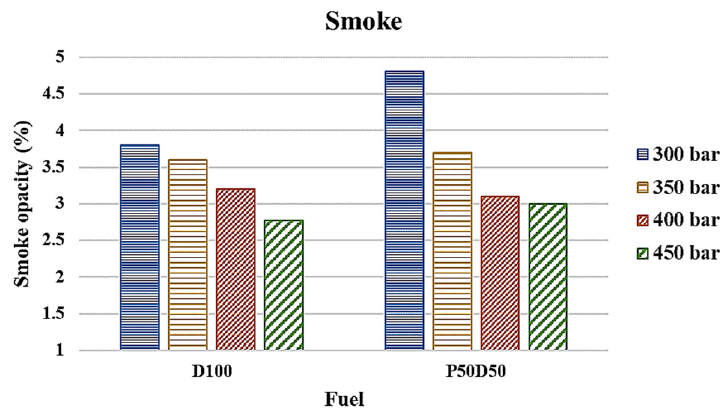
Figure 8. Smoke opacity under various injection pressures.